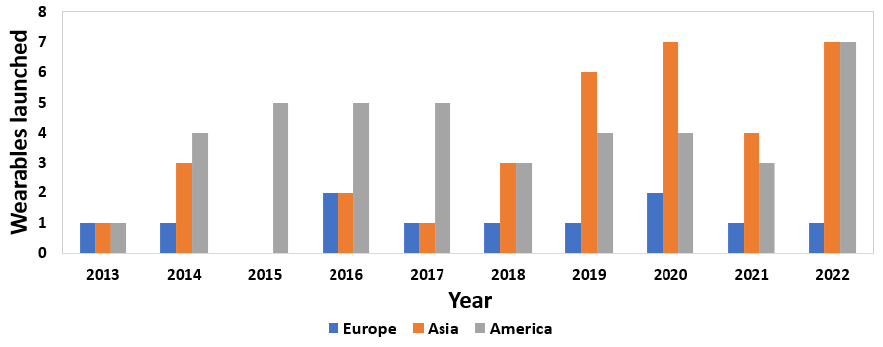
Figure 8. Location distribution of the developed commercial wearables by year.